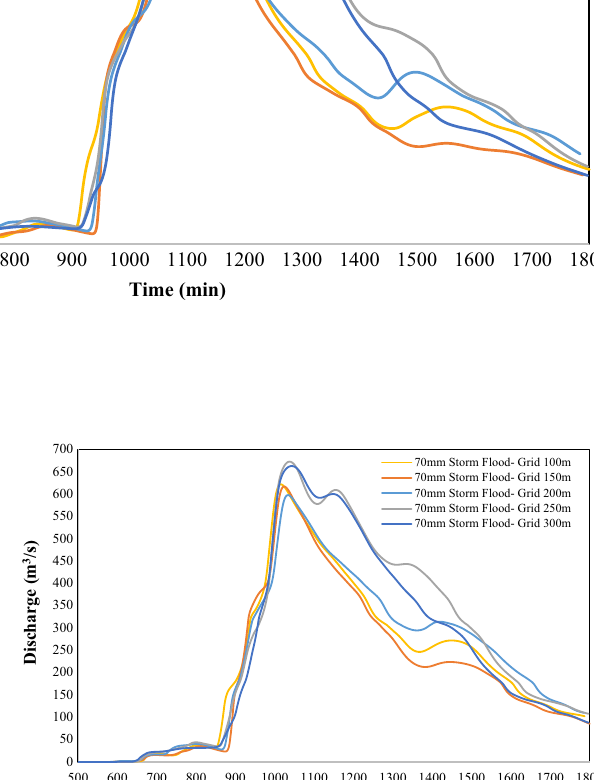
Fig. 19 Flood properties of calibrated GSSHA base model for a 24-h, 60 mm storm flood compared to hydrographs cor- responding to GSSHA models with cell sizes of 100–300 m